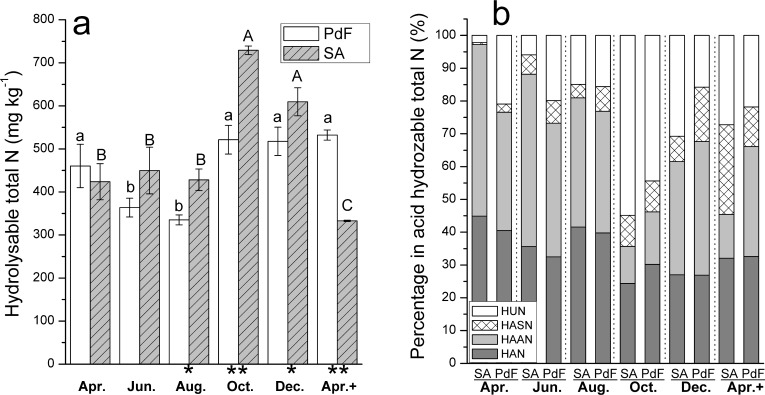
Bimonthly changes of the HTN in SA and PdF soils.